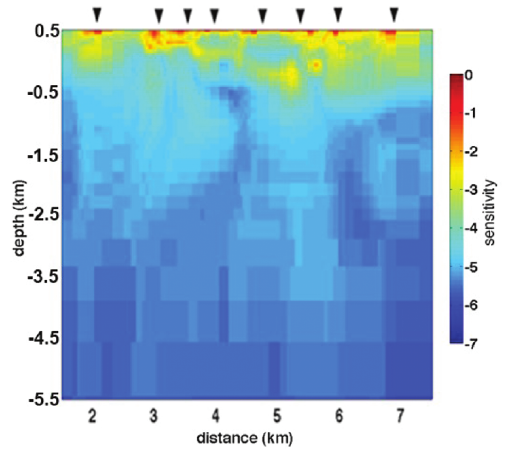
Fig. 9. Plot of the normalized sensitivity matrix re- lated to the model of fig. 6. Blocks in the sections where the common log of sensitivity takes values be- low − 5 are not